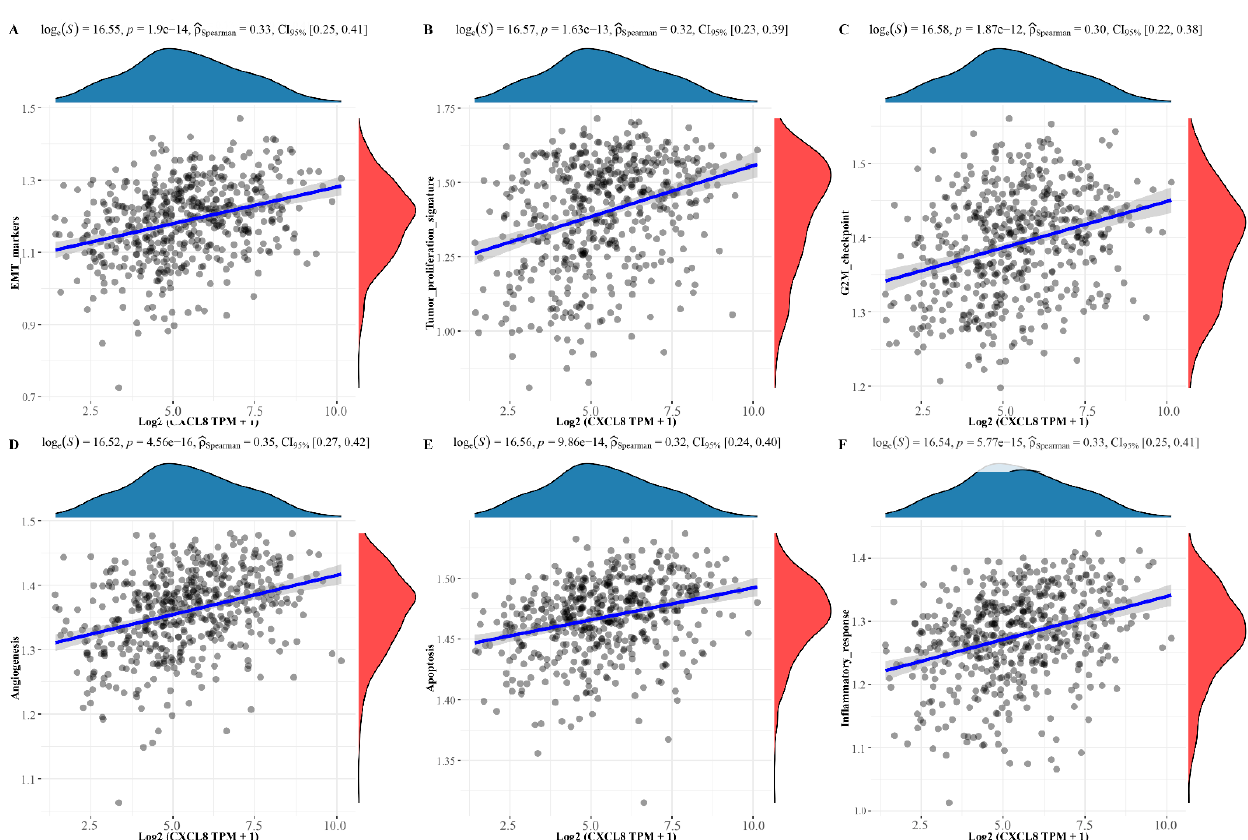
Figure 7. Pathway correlation analysis of CXCL8. ( A ) EMT makers. ( B ) Tumor proliferation. ( C ) G2-M checkpoint. ( D ) Angiogenesis. ( E ) Apoptosis. ( F ) Inflammatory response.